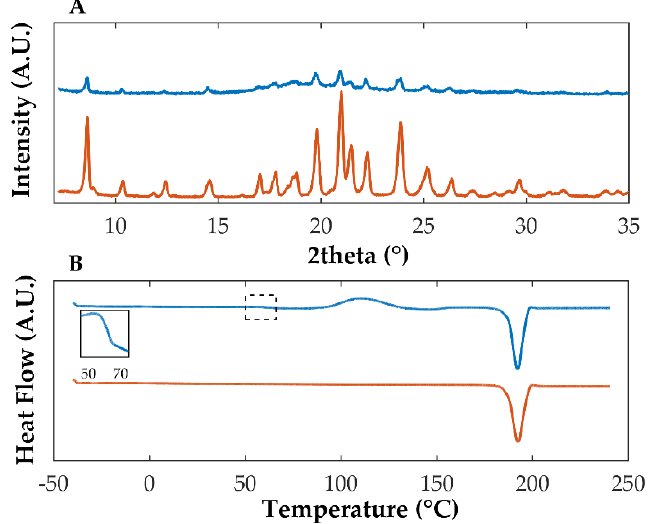
Figure 1. Diffractograms ( A ) and thermograms ( B ) of quench cooled (blue) and crystalline (orange) OLZ. The insert in thermogram B enlarges the glass transition region of amorphous OLZ.